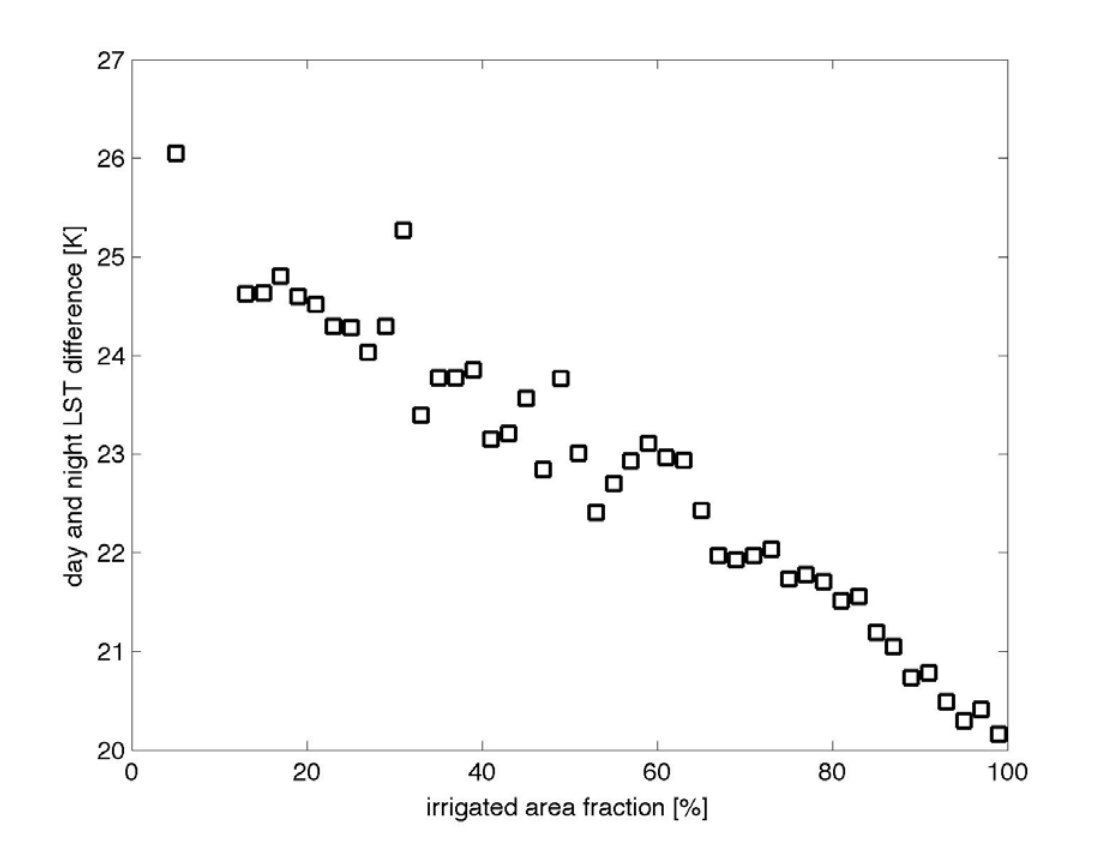
by MODIS. As the irrigation intensity increases, the modulating effect of evaporation and associated cooling of the land surface becomes more pronounced. This indicates that the could be used to map fractional coverage of irrigation using coarse resolution